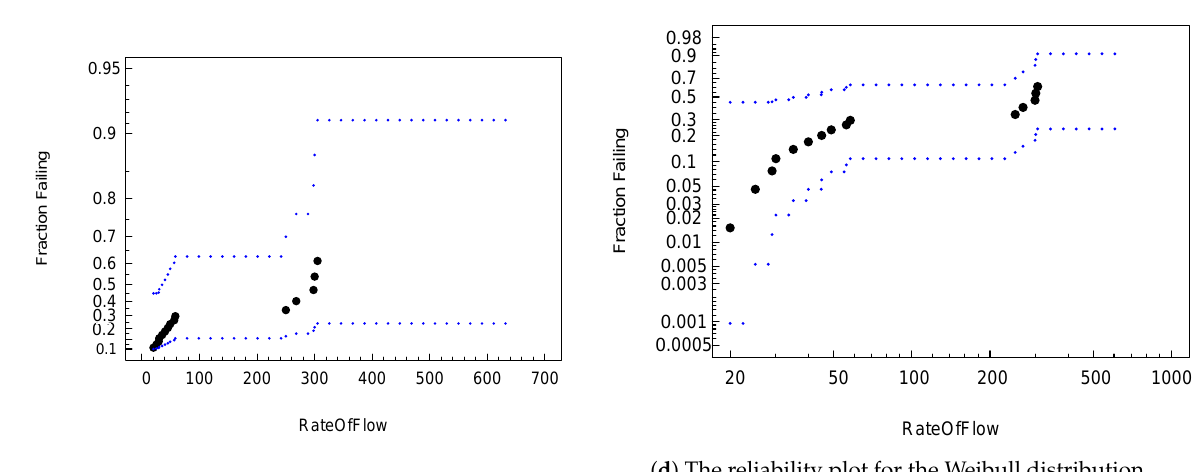
( b ) The reliability plot for the lognormal distribution.